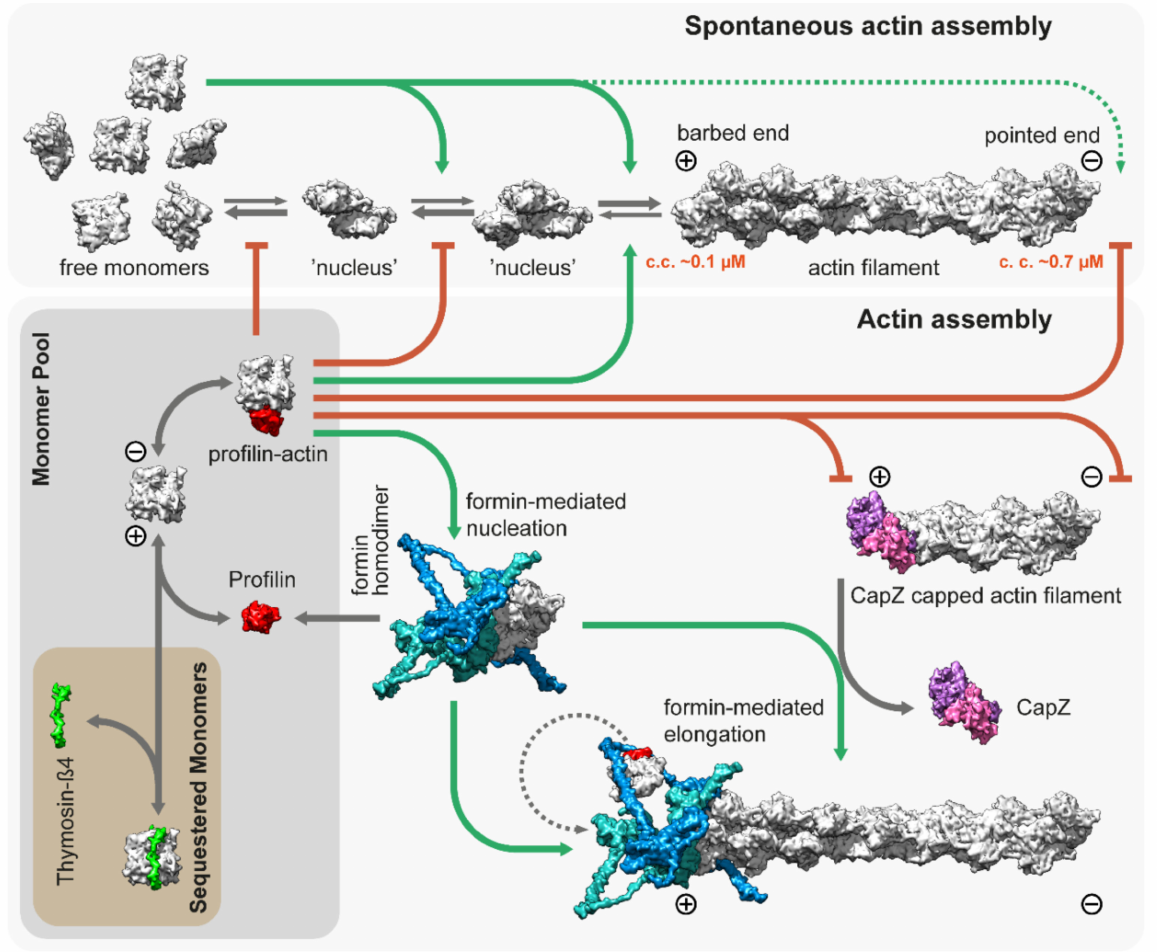
Figure 2. Spontaneous and regulated assembly of actin filaments. Free G-actin monomers can form nucleation seeds, which can elongate rapidly from both their barbed and pointed ends, although the critical concentration is significantly lower for the barbed ends (~0.1 µ M). Thymosin- β 4 sequesters actin monomers and prohibits uncontrolled actin assembly in vivo. Similarly, profilin [53]; PDB: 2BTF, bound to actin monomers, inhibits both spontaneous nucleation and growth from the pointed